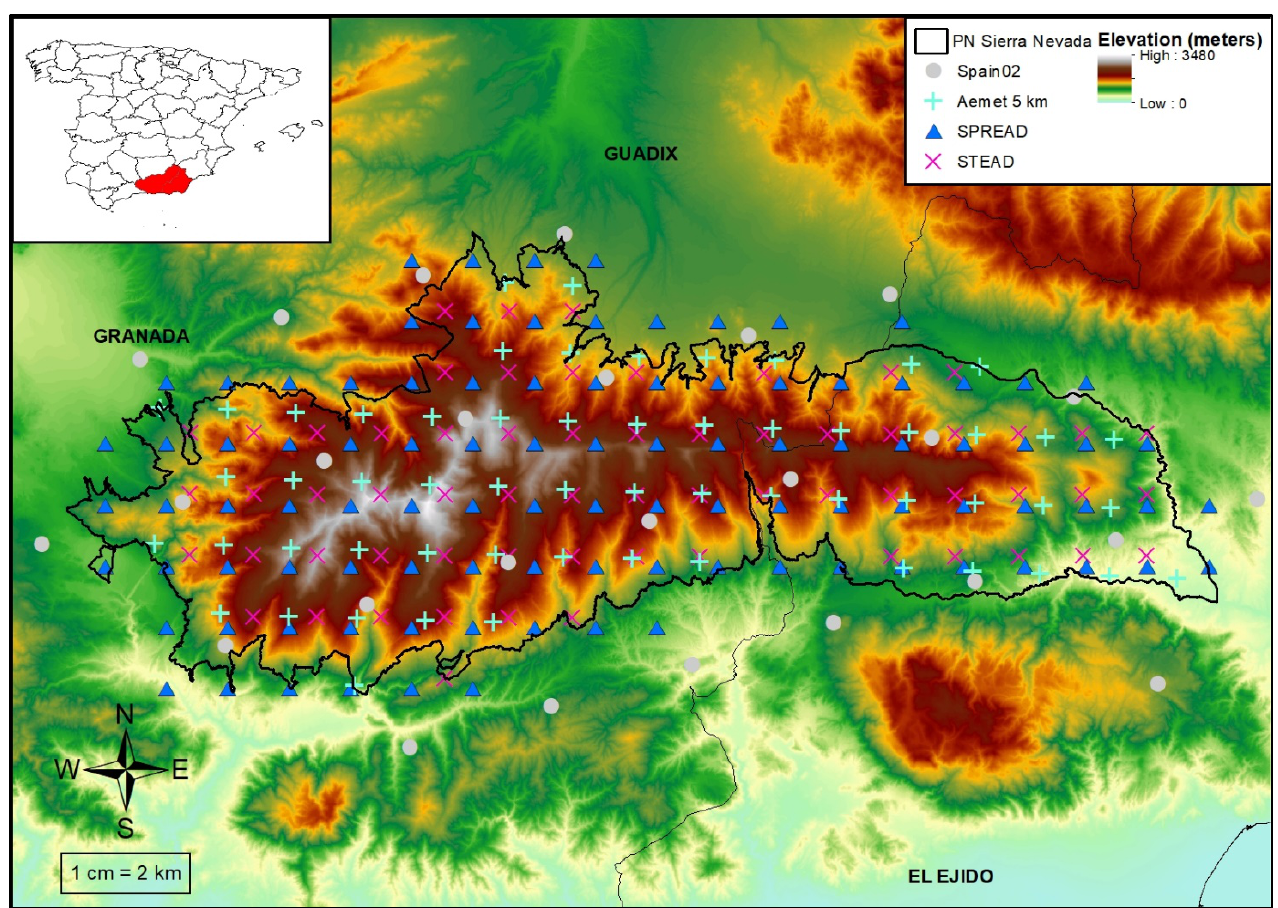
Figure 1. Case study location.